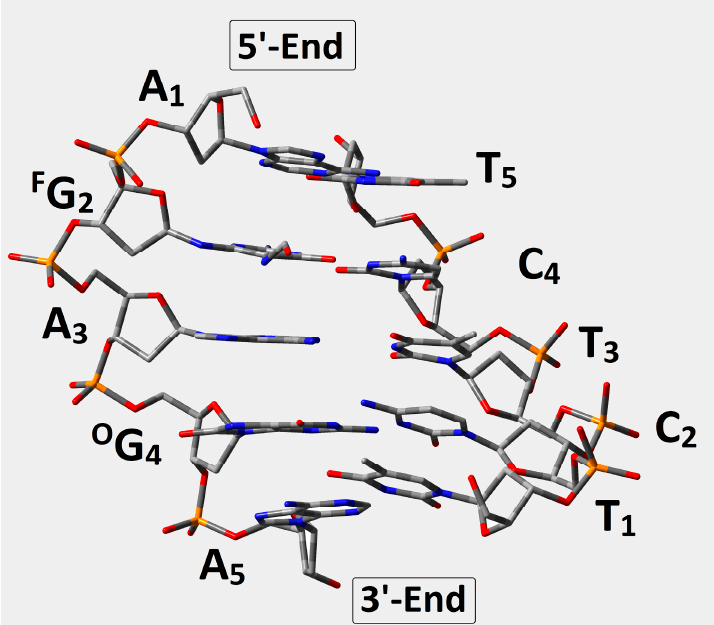
Figure 2. Graphical representation of d[A 1F G 2 A 3O G 4 A 5 ]*[T 1 C 2 T 3 C 4 T 5 ] optimized spatial geometry at the M06-2x/D95** level of theory in the aqueous phase using the PCM solvation model. F G: 2,6- diamino-4-hydrox-5-foramido-2 (cid:48) deoxypyrimidine, O G:7,8-dihydro-8-oxo-2 (cid:48) -deoxyguanosine.